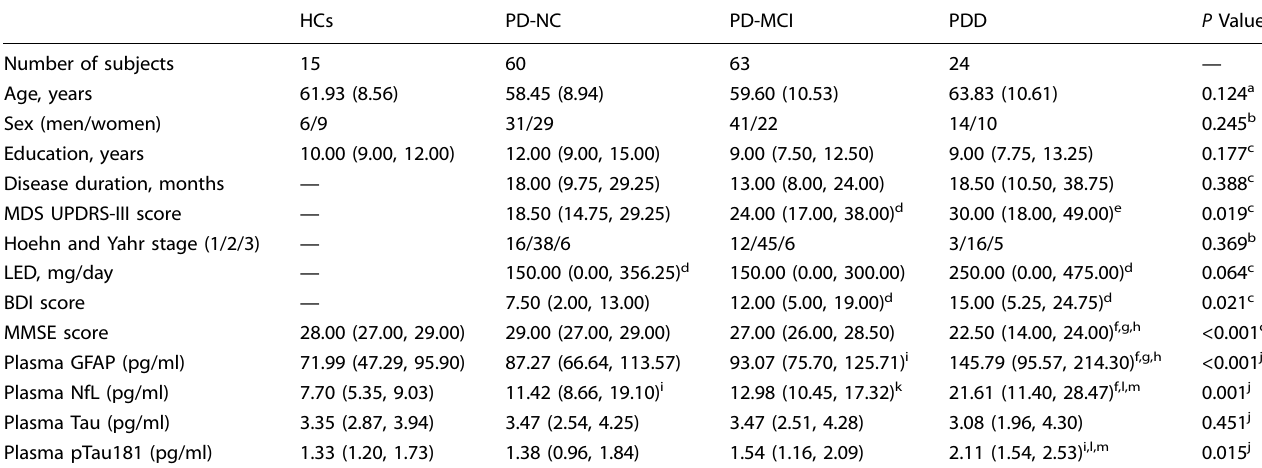
Table 1. Demographic and clinical characteristics of the study